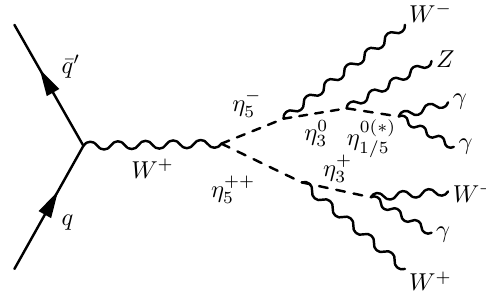
Figure 3. Cross sections for the Drell-Yan production of SU (5) / SO (5) pNGBs at the LHC with √ s = 13 TeV, assuming the same mass for all states of the custodial singlet, triplet, and quintuplet. Note that the η 0 combination is not allowed as they are both parity-odd. η 0 1 5